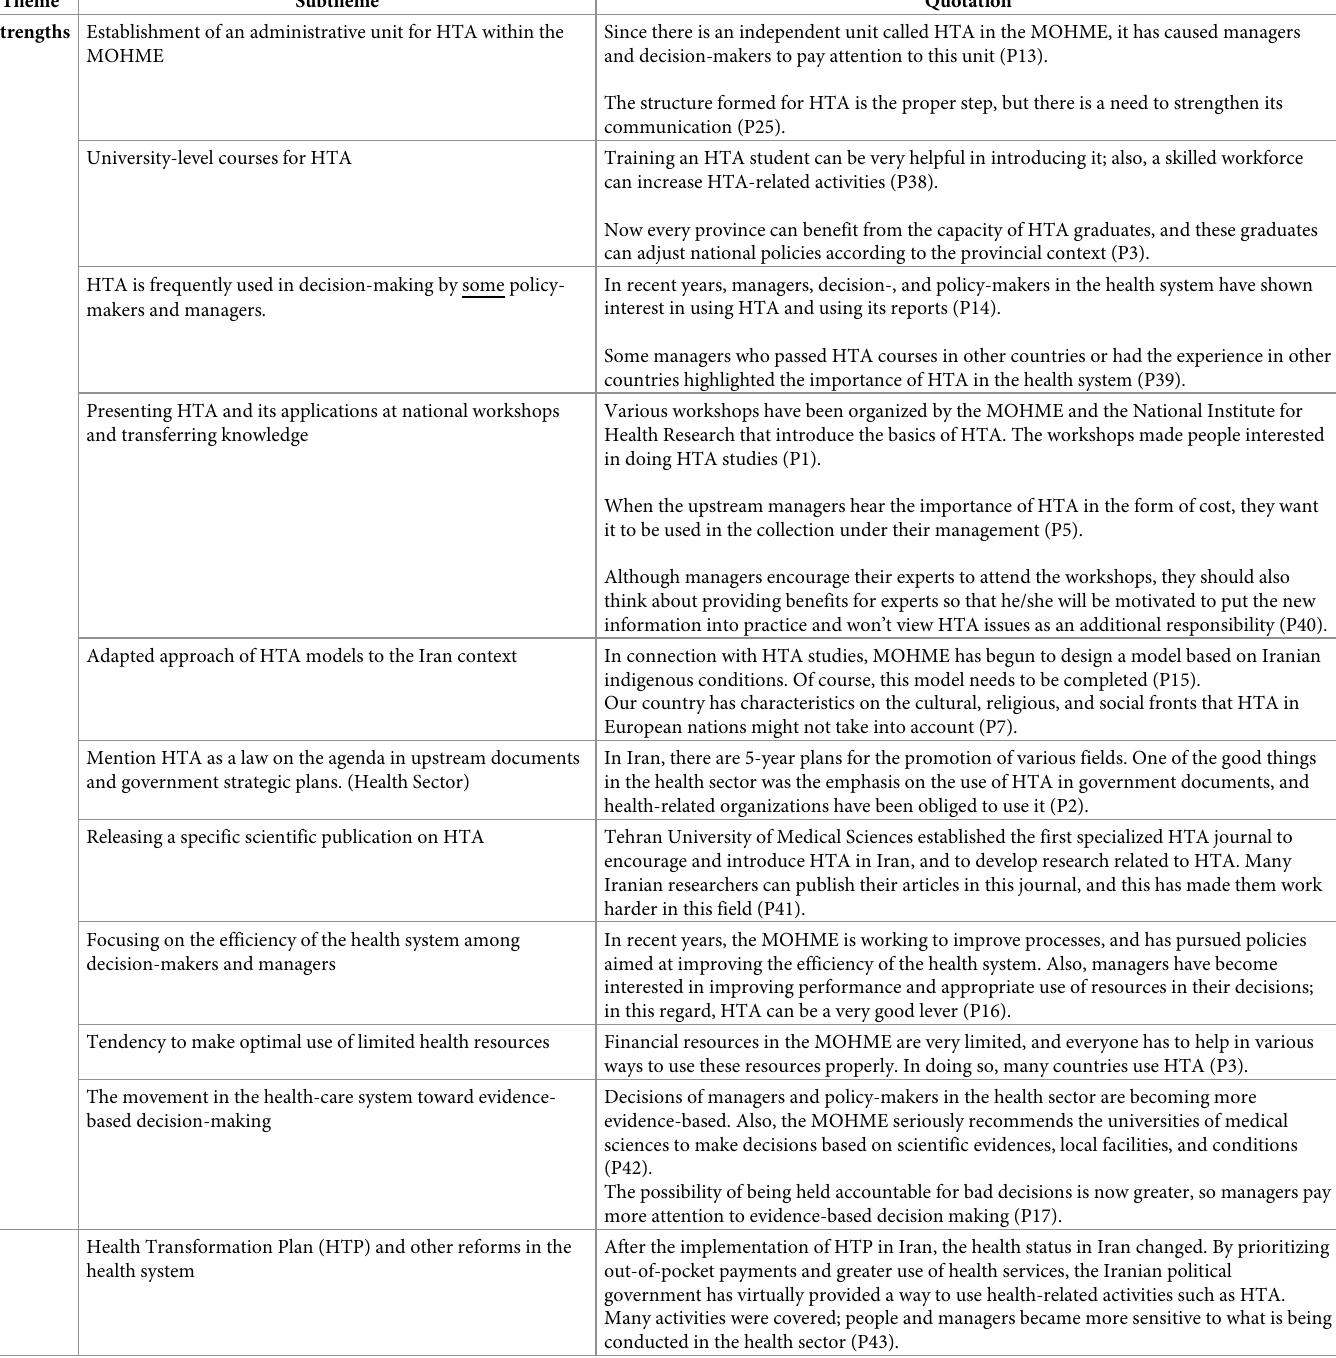
Table 3. The subthemes and quotations of the strengths of developing the HTA in